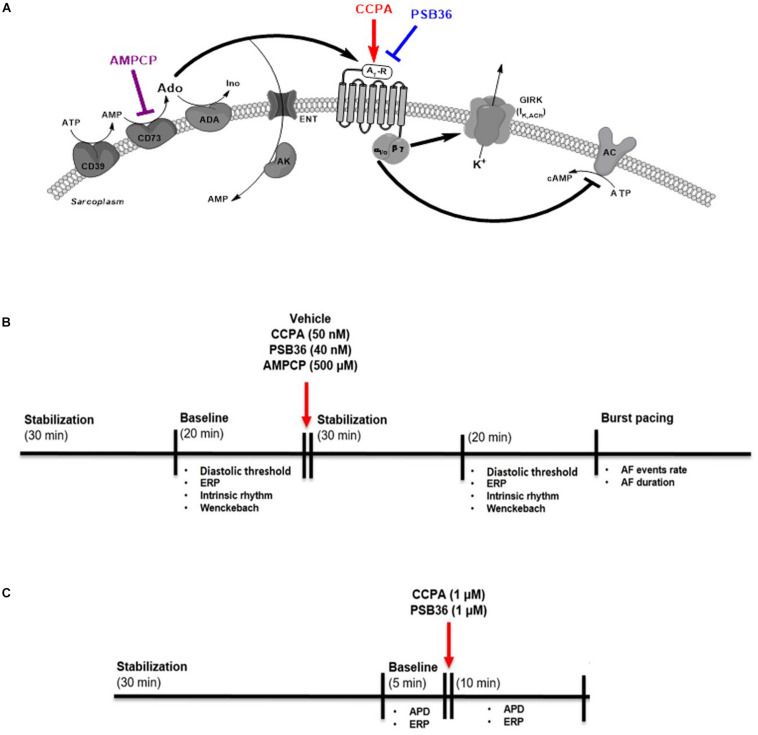
(A) Adenosine (Ado) pathway in cardiomyocytes. Adenosine release is regulated by the ectonucleotidases CD39 and CD73. CD39 converts ATP and ADP into AMP, while CD73 converts AMP into adenosine. Extracellular adenosine half-life is determined by adenosine deaminase (ADA) conversion to inosine (Ino) or internalization by specific equilibrative nucleoside transporters (ENT). A1-receptor activation increases K+ permeability for the G-protein-coupled inwardly rectifying K+ (GIRK) channel through the Gβγ and inhibits the adenylyl cyclase (AC) through Giα subunit. 2-Chloro-N6-cyclopentyladenosine (CCPA) is a potent A1-R agonist; 1-butyl-3-(3-hydroxypropyl)-8-(3-noradamantyl)xanthine (PSB36) specifically antagonizes A1-R signaling. 5′-(α,β-methylene) diphosphate sodium salt (AMPCP) inhibits CD73. (B) Experimental protocol on isolated perfused male Wistar rat hearts. Hearts were removed and placed on the Langendorff configuration. After stabilization phase and baseline, hearts were perfused with vehicle, CCPA, PSB36, or AMPCP, respectively. Each group was paced at CL of 200, 150, and 100 ms. At the end of each experiment, the hearts were exposed to high-frequency pacing events in order to induce AF. (C) Experimental protocol on intact contracting muscles from human right atrial appendages (hRAAs). Human atrial tissues were paced at CL of 1.0 s. After stabilization phase, baseline was recorded for 5 min. After that, hRRAs were exposed to CCPA or PSB36, respectively, for 10 min.